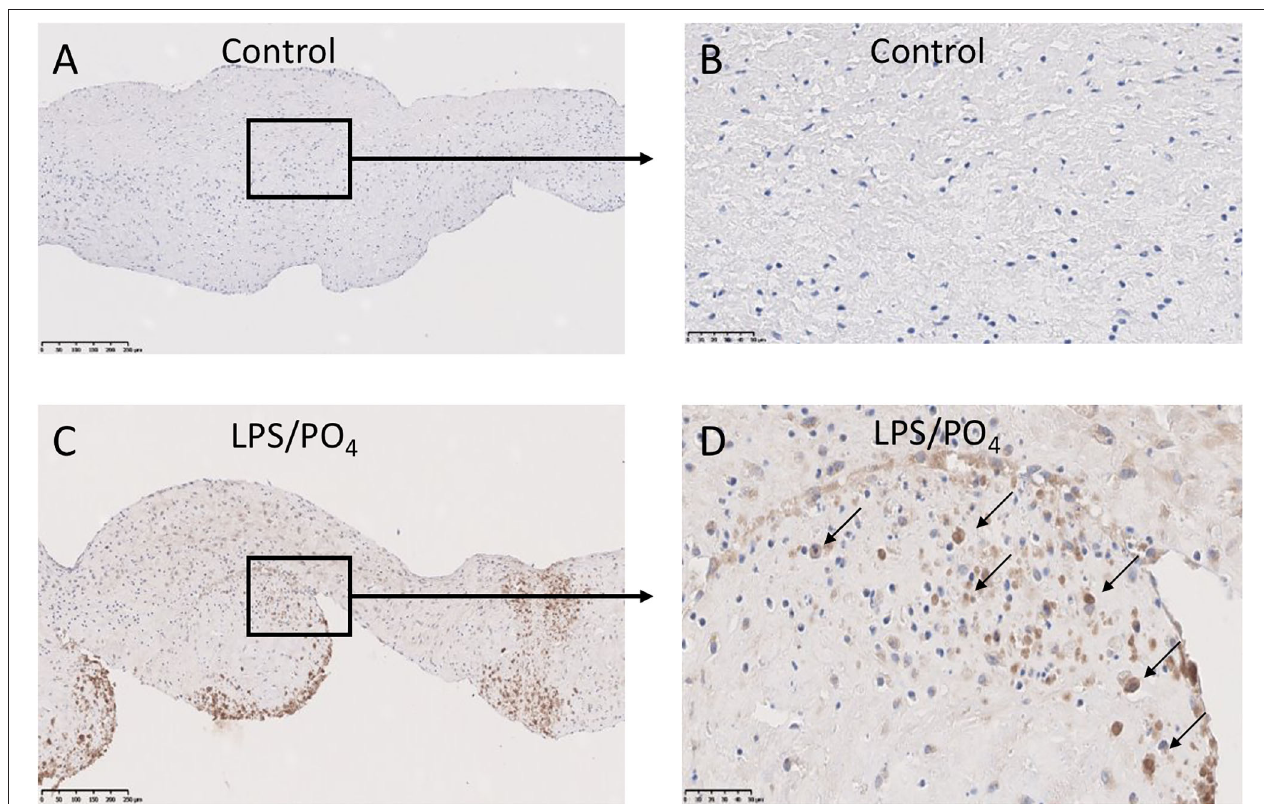
FIGURE 6 | Expression of NF-kB in calcified valve leaflets. Low and high-powered images of immunohistochemical staining for NF-kB in untreated (A,B) and 100ng/mL LPS & 3mM phosphate treated (C,D) valve leaflets. Nuclear expression of NF-kB can be seen in (D) (black arrows). (A,C) scale bar, 200 µ M; (B,D) scale bar, 500 µ